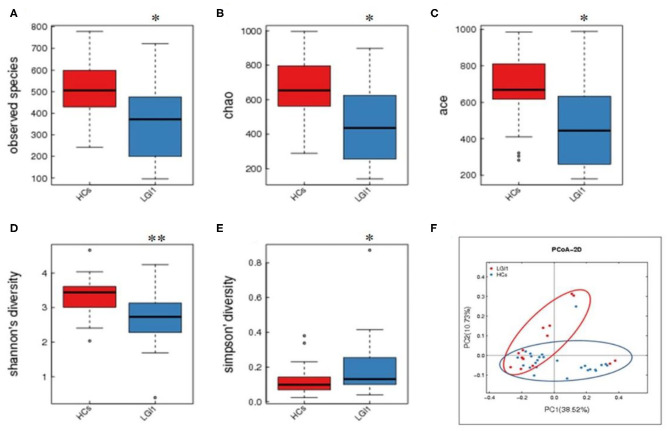
Reduced microbial diversity and altered overall microbial composition detected in anti-LGI1 encephalitis. (A–E) Alpha-diversity in anti-LGI1 encephalitis patients and HCs. Box plots depict reduced microbial diversity in anti-LGI1 patients according to observed species, Chao1, ace, Shannon diversity, and Simpson diversity index. Lines inside the box represent the median values, the upper and lower ranges of the box represent the interquartile range values, and the horizontal lines depict minimum and maximum values (*p < 0.05, **p < 0.01). (F) Beta-diversity analysis in the two groups. Weighted PCoA based on the UniFrac distance illustrate the microbial community variation between the anti-LGI1 encephalitis and HCs (pseudo-F: 3.84, p < 0.001).